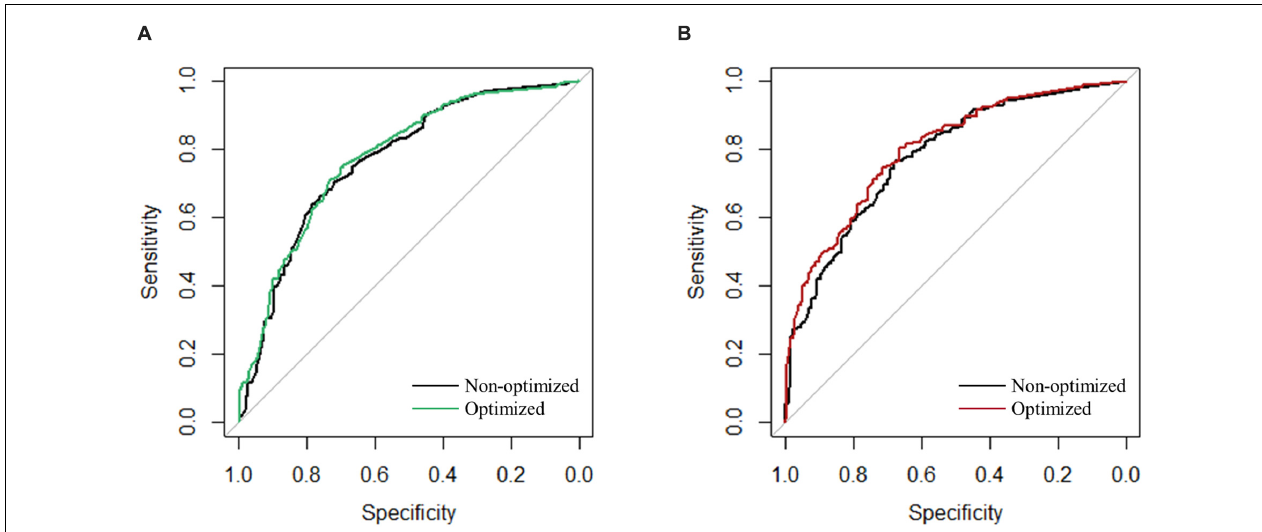
FIGURE 9 | ROC curve before and after optimization. (A) Anti- E. coli model (NN model after Bagged CART selection). (B) Anti- S. aureus model (NN model after LDA